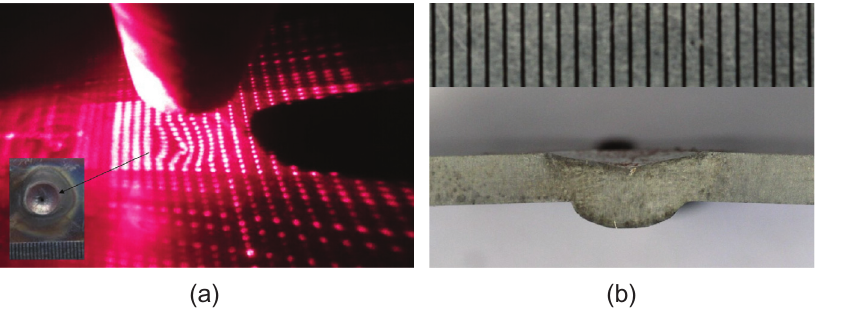
Figure 4: Weld pool appearance at the welding current of 70A. (a) The front feature of weld pool. (b) The cross-section macroscopic feature of weld pool.